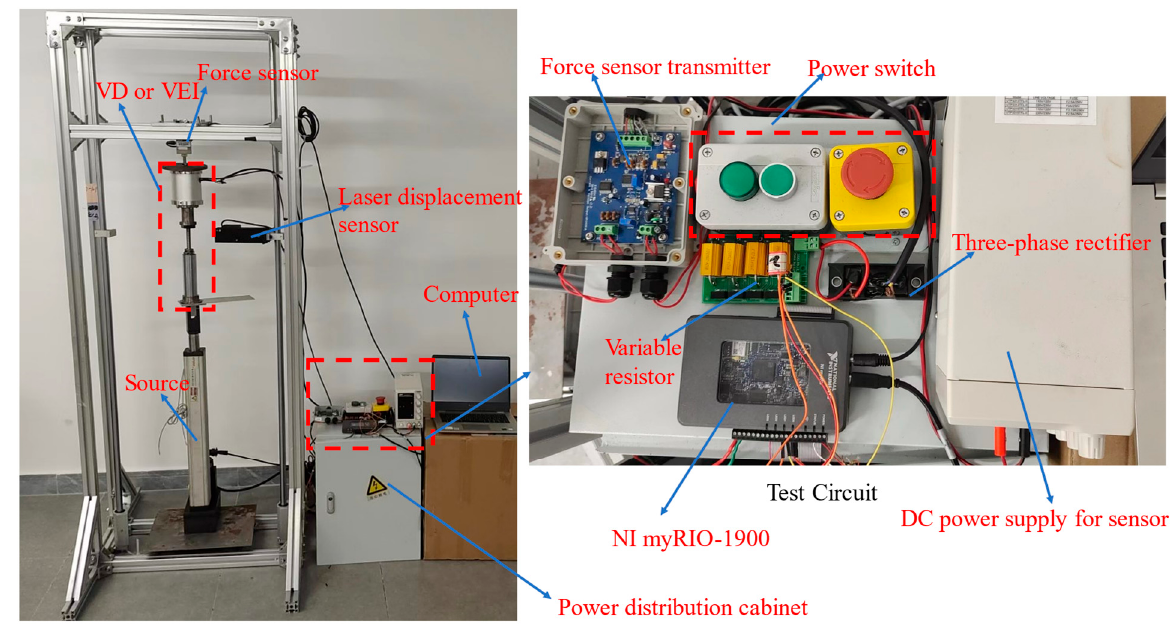
Figure 7. Time-domain test bench